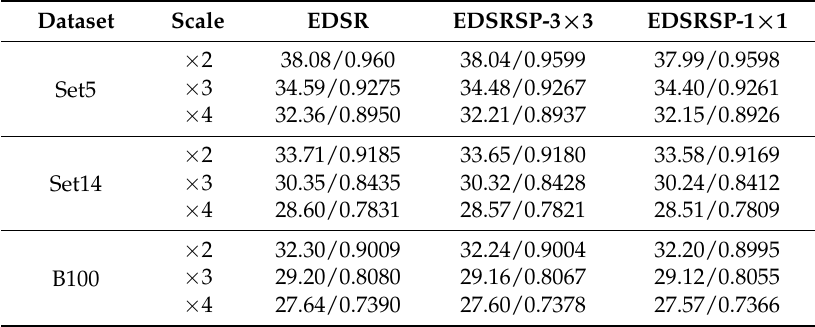
Table 4. Public benchmark test results (PSNR